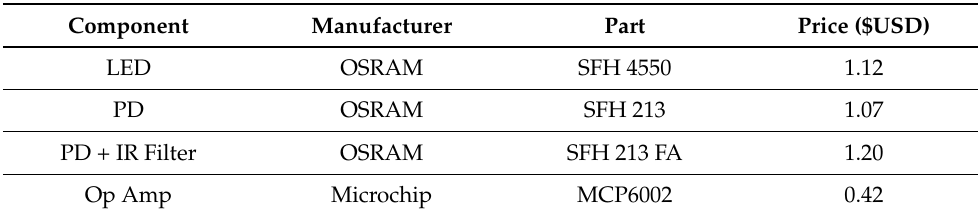
Table 2. List of the major circuit components and their cost. Prices obtained from Digikey